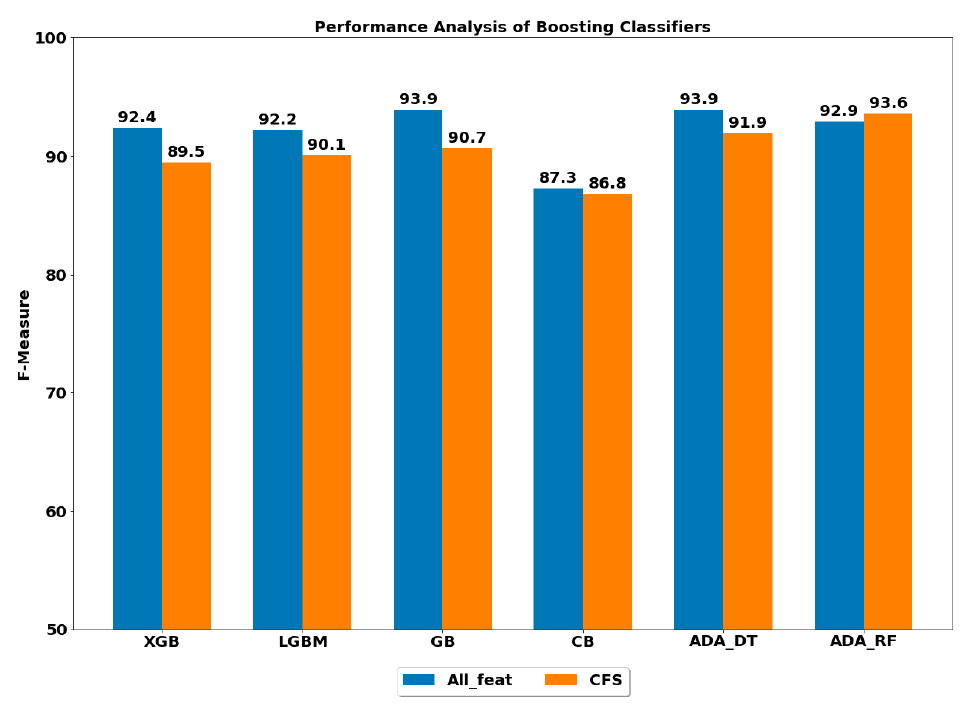
Figure 2. Performance analysis of various boosting classifiers with and without feature selection. Table 3. Confusion matrix of best-performing classifier (GB) using all feature set.